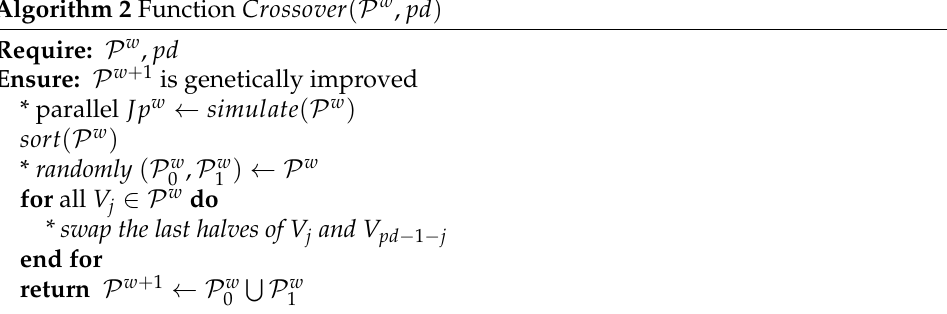
Algorithm 2 Function Crossover ( P w , pd